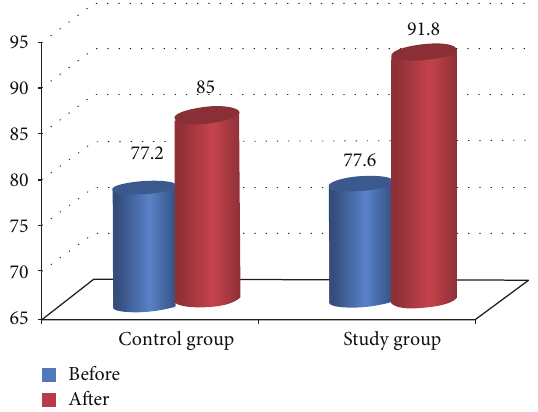
Figure 5: Comparison between pre- and posttreatment in stride speed for both groups.